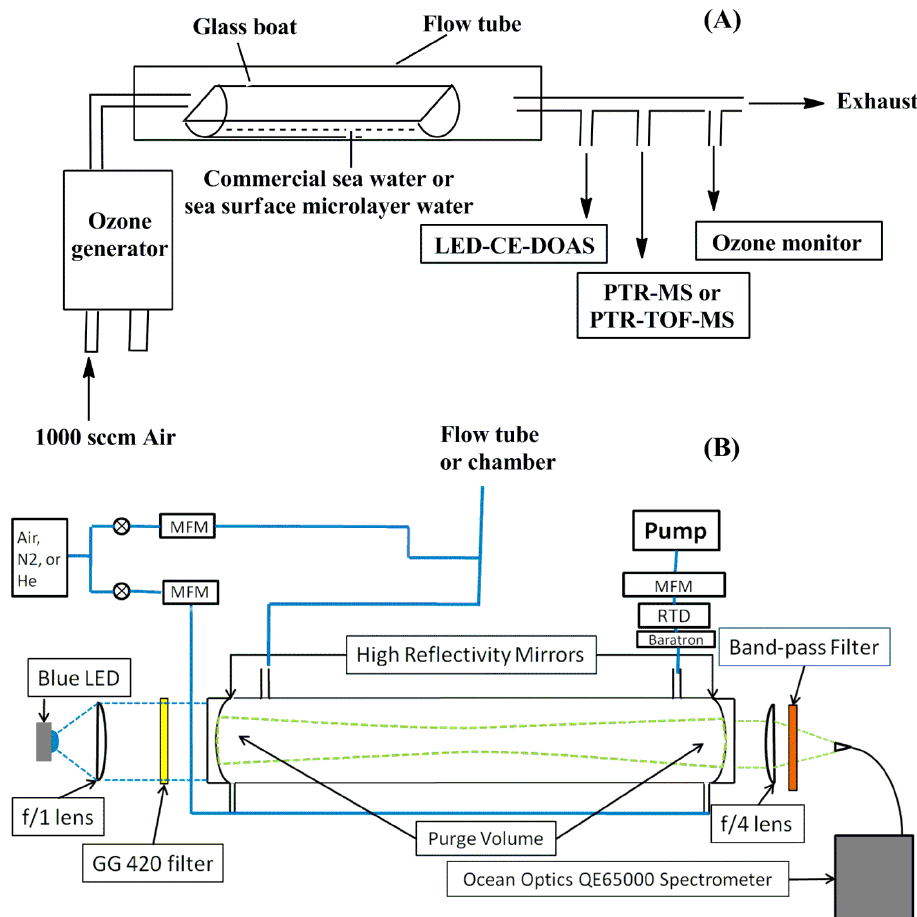
Fig. 1. Schematic of the flow tube apparatus (A) and LED-CE-DOAS instrument (B)